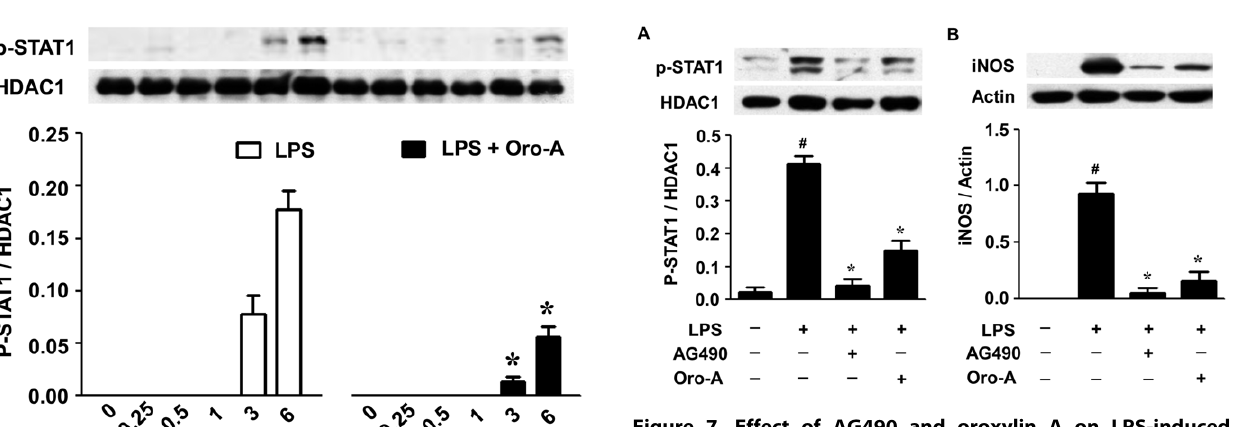
Figure 7. Effect of AG490 and oroxylin A on LPS-induced STAT1 phosphorylation and iNOS expression in BV-2 cells. ( A ) BV-2 cells (2 6 10 6 cells/dish) were incubated with AG490 (20 m M), a specific JAK2 inhibitor, or oroxylin A (Oro-A, 50 m M) in the presence of LPS (100 ng/ml). After 16 hours, nuclear proteins were isolated and examined by Western blot analysis using specific antibodies against p- STAT1 and HDAC1. A representative Western blot is shown in upper panel. The ratio of p-STAT1 to HDAC1 is calculated and shown in bottom panel. ( B ) Cells (2 6 10 6 cells/dish) were treated with LPS (100 ng/ml) and AG490 (20 m M)/oroxylin A (50 m M) for 16 hours. Effects of AG490 and oroxylin A on LPS-induced iNOS protein expression were determined by Western blot analysis. A representative Western blot is shown in upper panel and the ratios of iNOS to actin are shown in panel below. All results are expressed as means 6 SEM from three indepen- dent experiments. # , p , 0.05, one-way ANOVA followed by Tukey’s post hoc test compared with vehicle-treated cells; * , p , 0.05, one-way ANOVA followed by Tukey’s post hoc test compared with LPS-treated